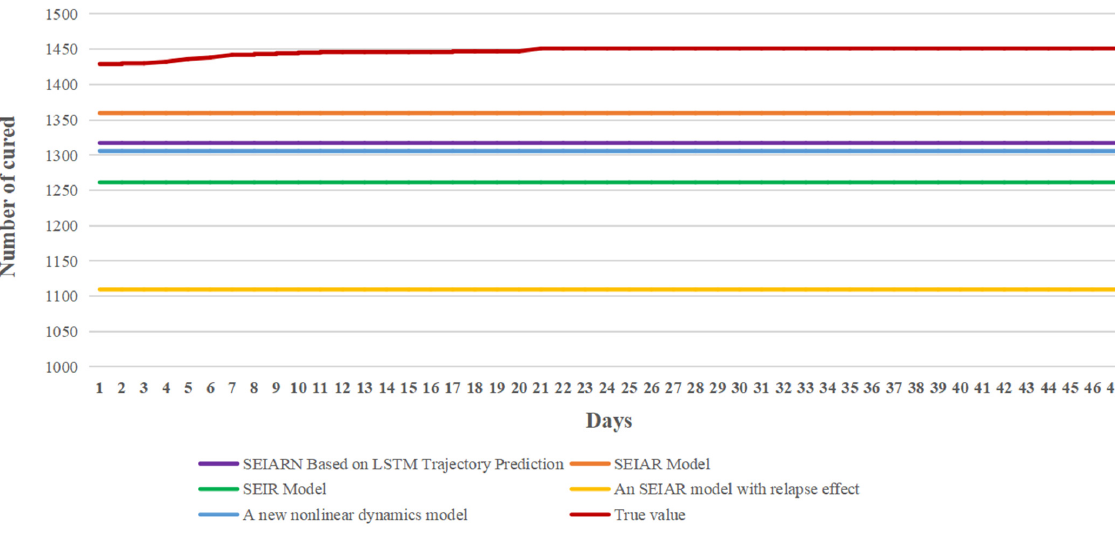
Figure 21. Comparison chart of the number of cured people.